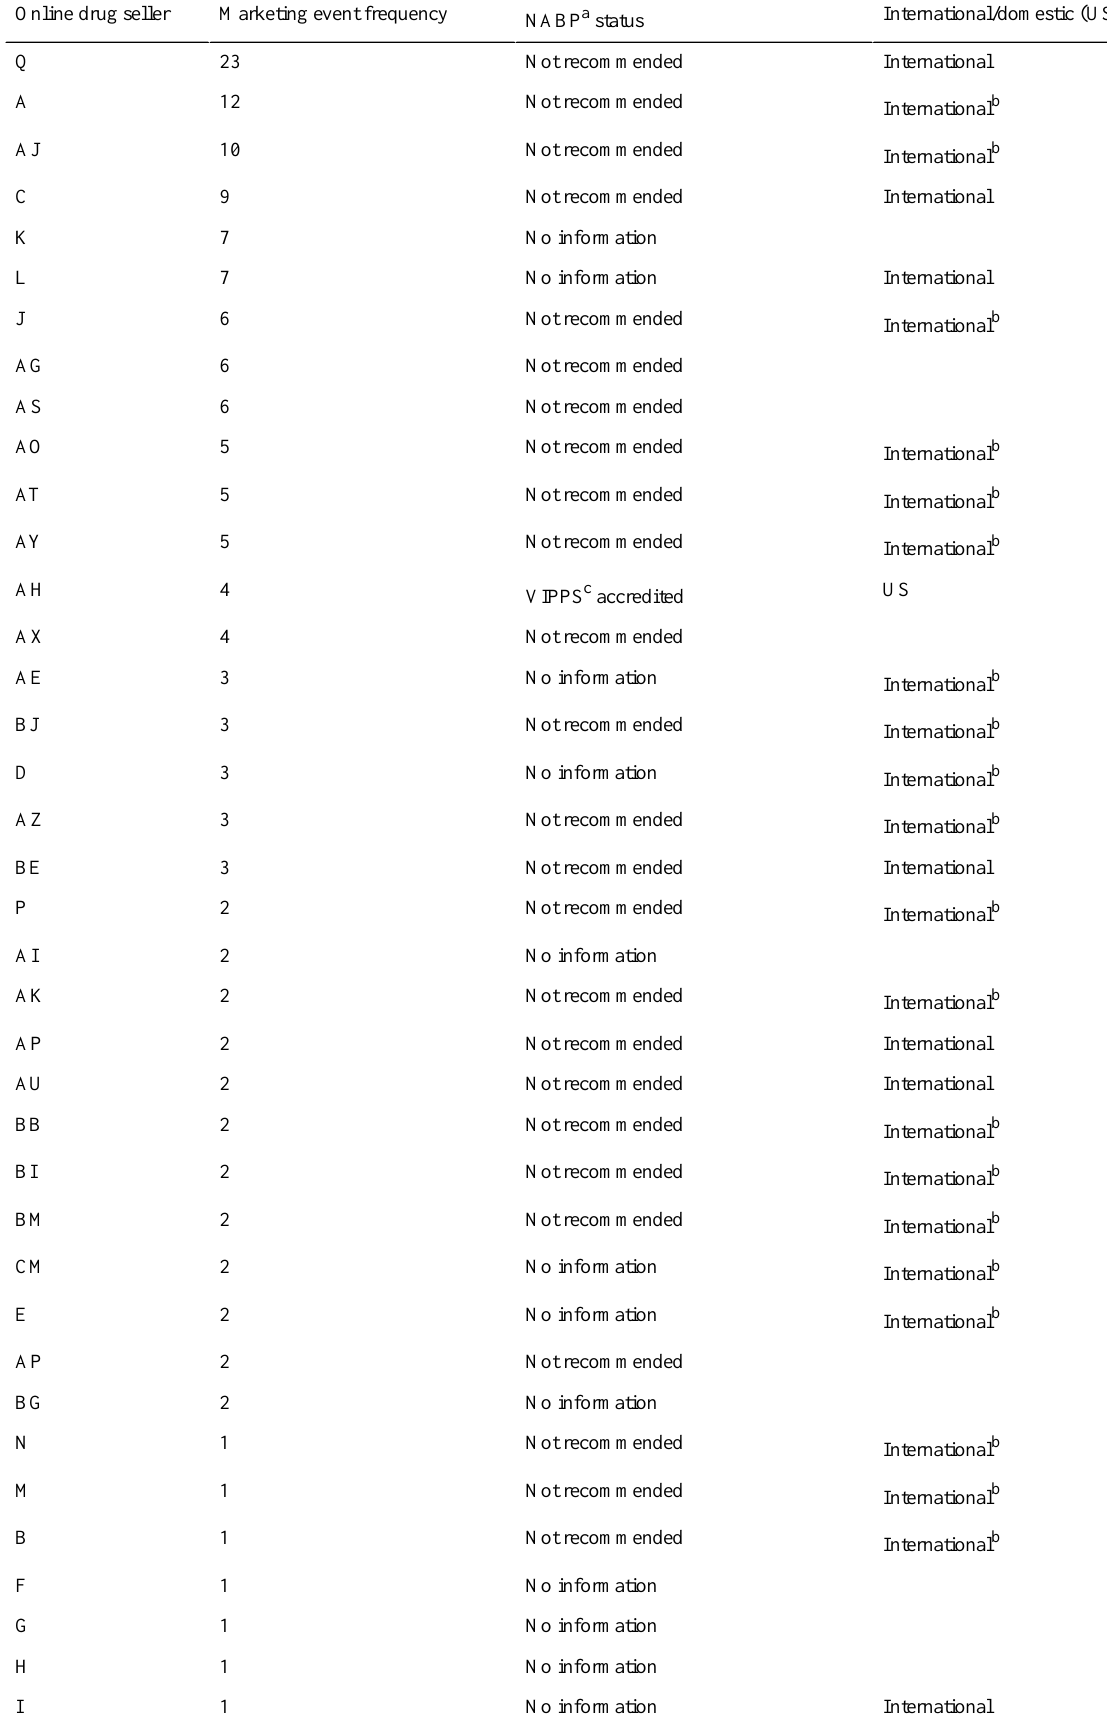
Table 2. Characteristics of Internet shortage drug